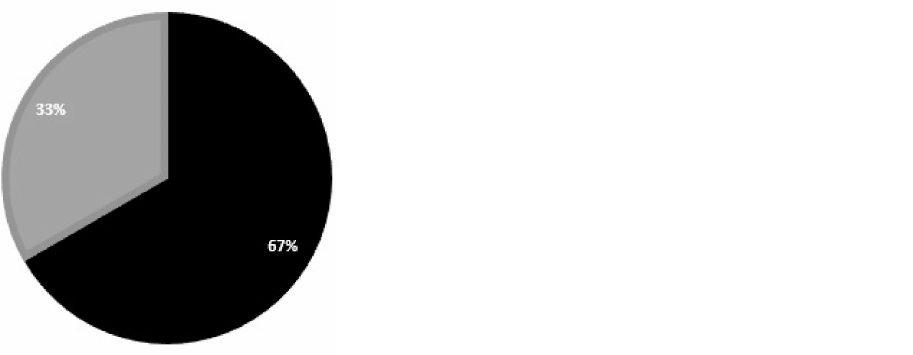
Figure 5. Percentage of handball players with DOMS after the fatiguing